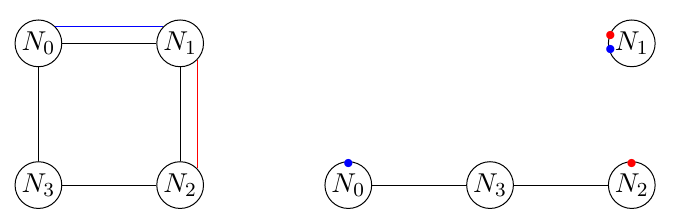
Figure 17 . Left: b A 3 quiver with two supersymmetric Schur polynomial insertions, represented as a blue and a red line respectively. Right: the same quantity is factorized into two disjoint sub-quivers, with blue and red dots denoting ordinary Schur polynomial